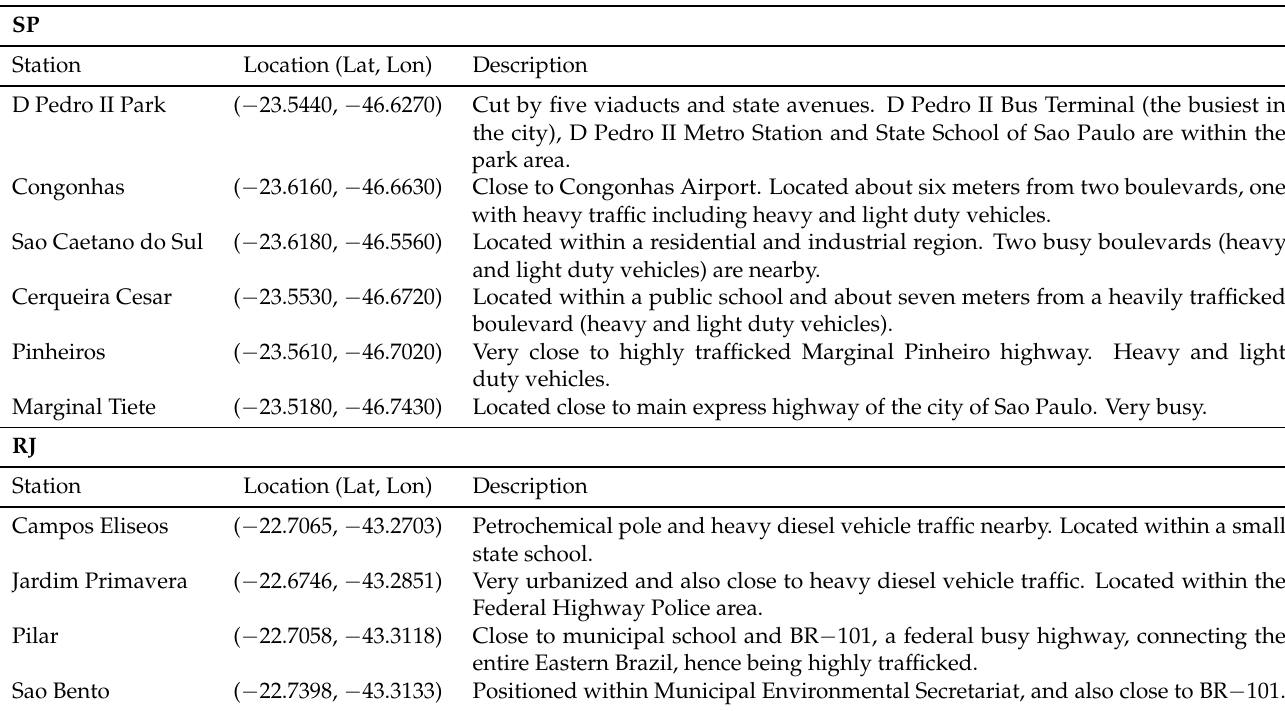
Table 2. The selected ground stations in SP and